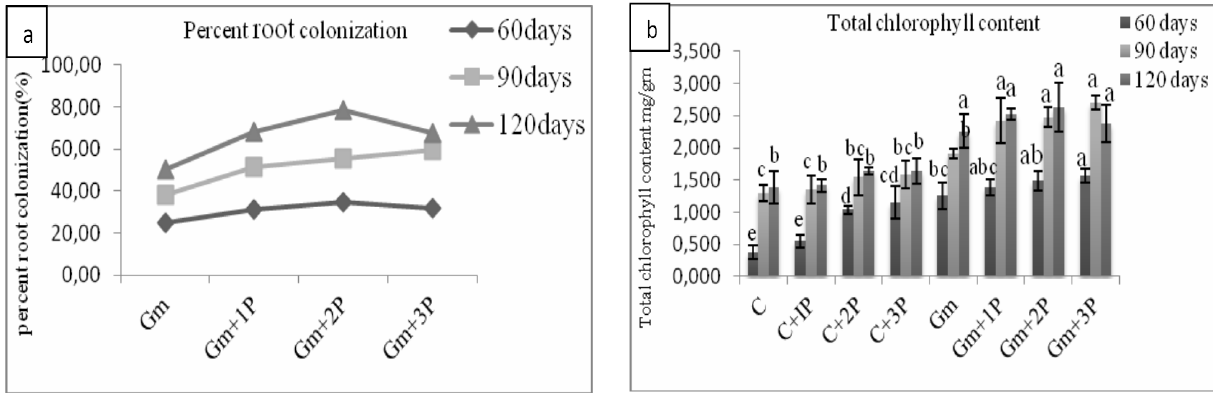
Fig. 1. Percentage of AM colonization and total chlorophyll content of Solanum melongena L. after 60, 90 and 120 days of AM treatment